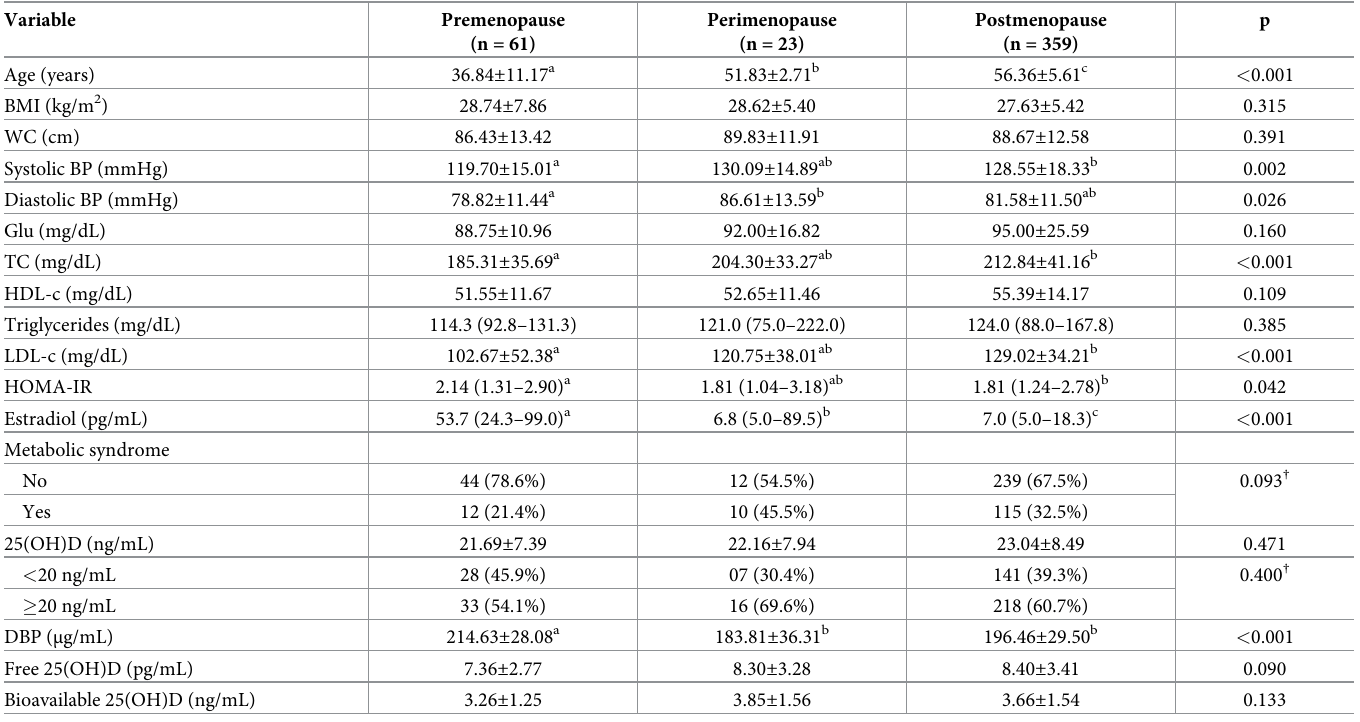
Table 1. Clinical and biochemical profile of participants according to menopause status.